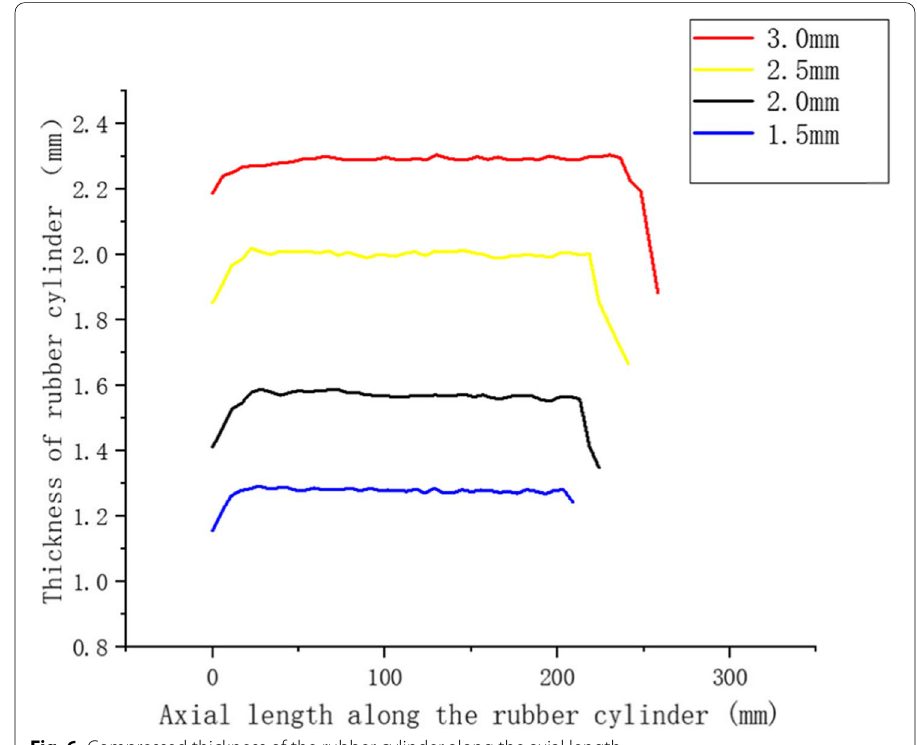
Fig. 6 Compressed thickness of the rubber cylinder along the axial